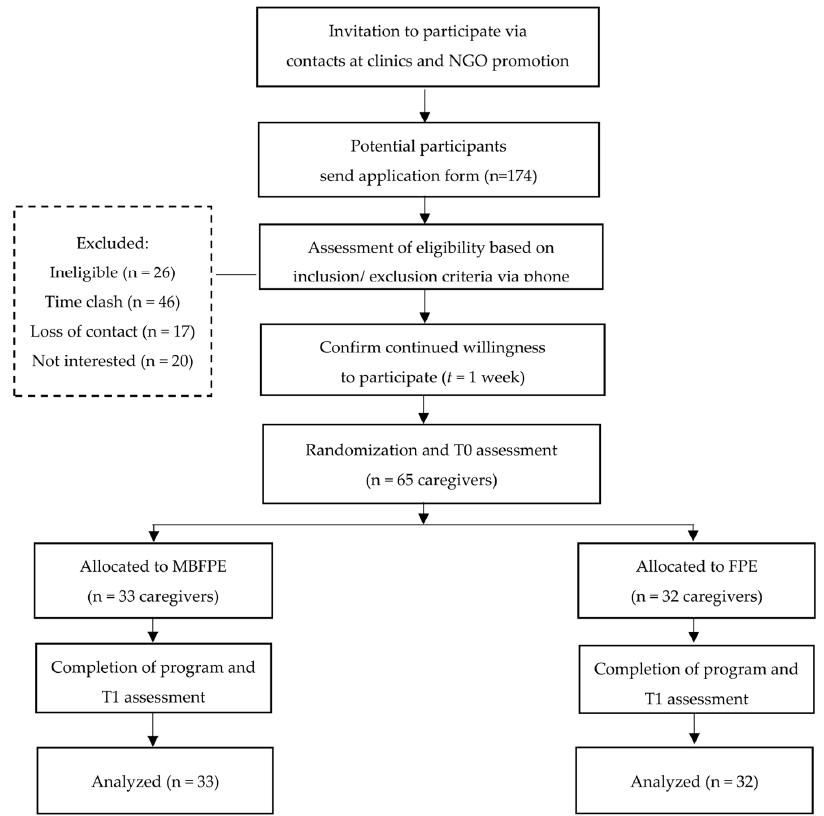
Figure 1. Flow diagram of the process for randomized controlled trial.